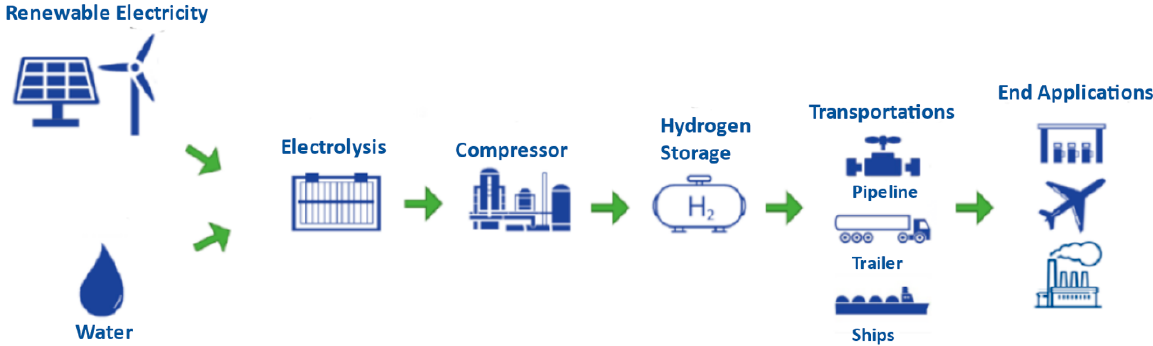
Figure 5. Overview of the general process of green hydrogen production.